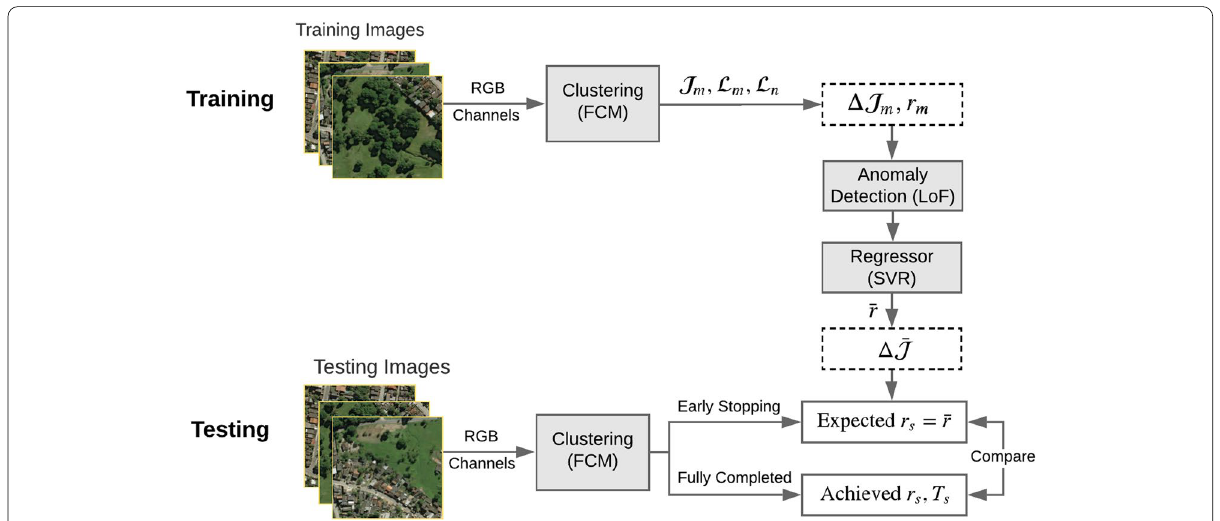
Fig. 3 Framework of cost-effective remote sensing image